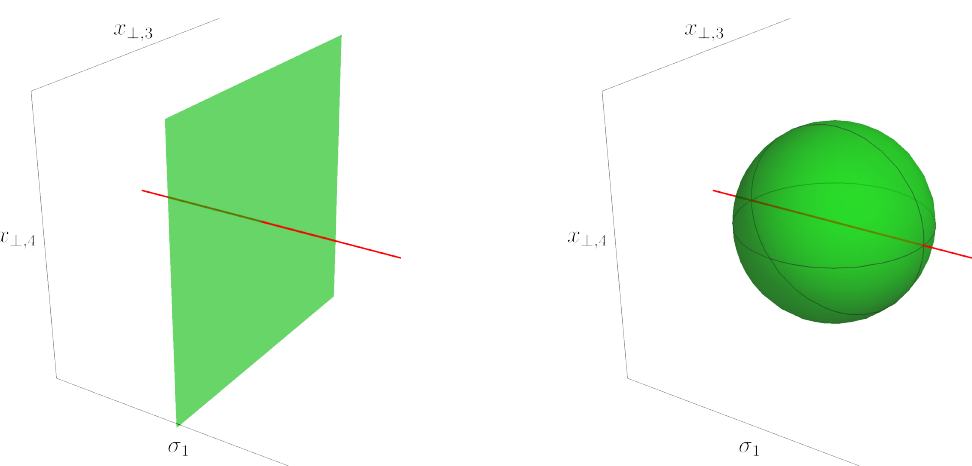
Figure 1. Left: sketch of the configuration we employ to compute the defect contribution to EE in d = 4 . The figure is an instance in time at τ = 0 . The defect extends along the σ 1 direction, while the entangling surface extends along the remaining orthogonal directions and intersects the defect at σ 1 = 0